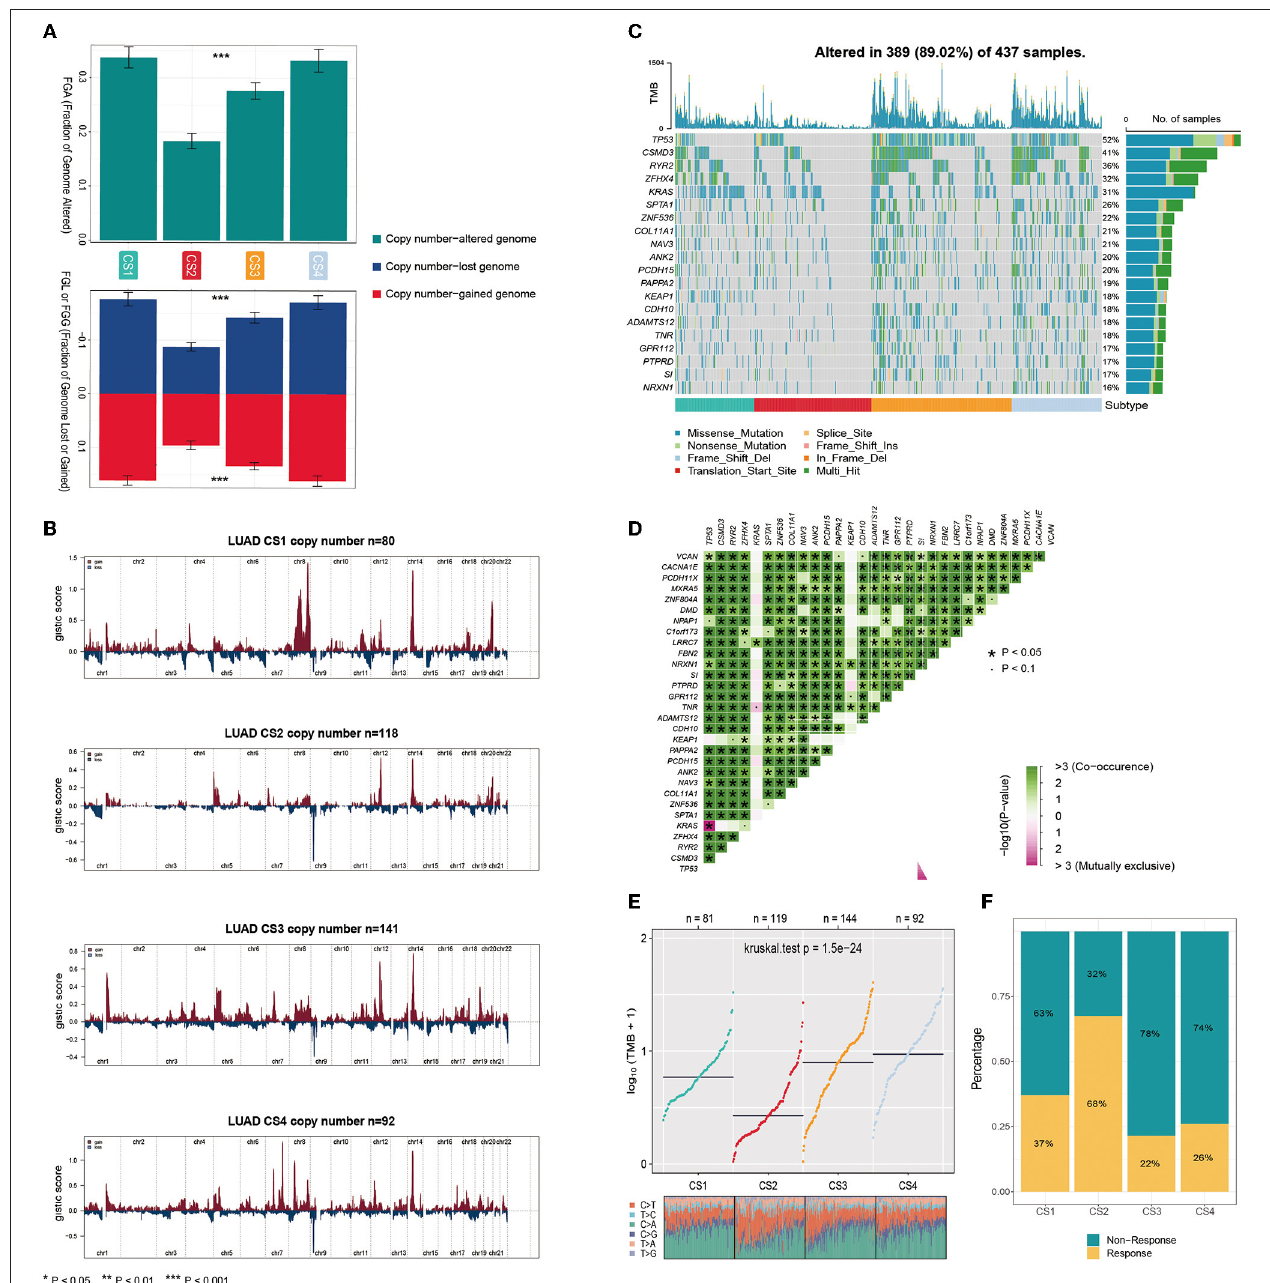
FIGURE 3 | (A) Bar plot of fraction genome altered among the four subtypes. (B) The copy number amplifications and deletions among the 22 chromosomes in the four subgroups. (C) The waterfall plot shows the somatic mutation landscape of the top 15 most frequently mutated genes. The bar plot above the heatmap denotes the number of mutations occurring for each subject and the right side bar plot shows the number of subjects having a mutation for each gene. (D) The heatmap shows the mutually co-occurring and exclusive mutations of the top 30 frequently mutated genes. (E) Comparison of TMB and TiTv (transitions and transversions) among the four subtypes. (F) The bar plot of immunotherapy responders and non-responders predicted by the TIDE